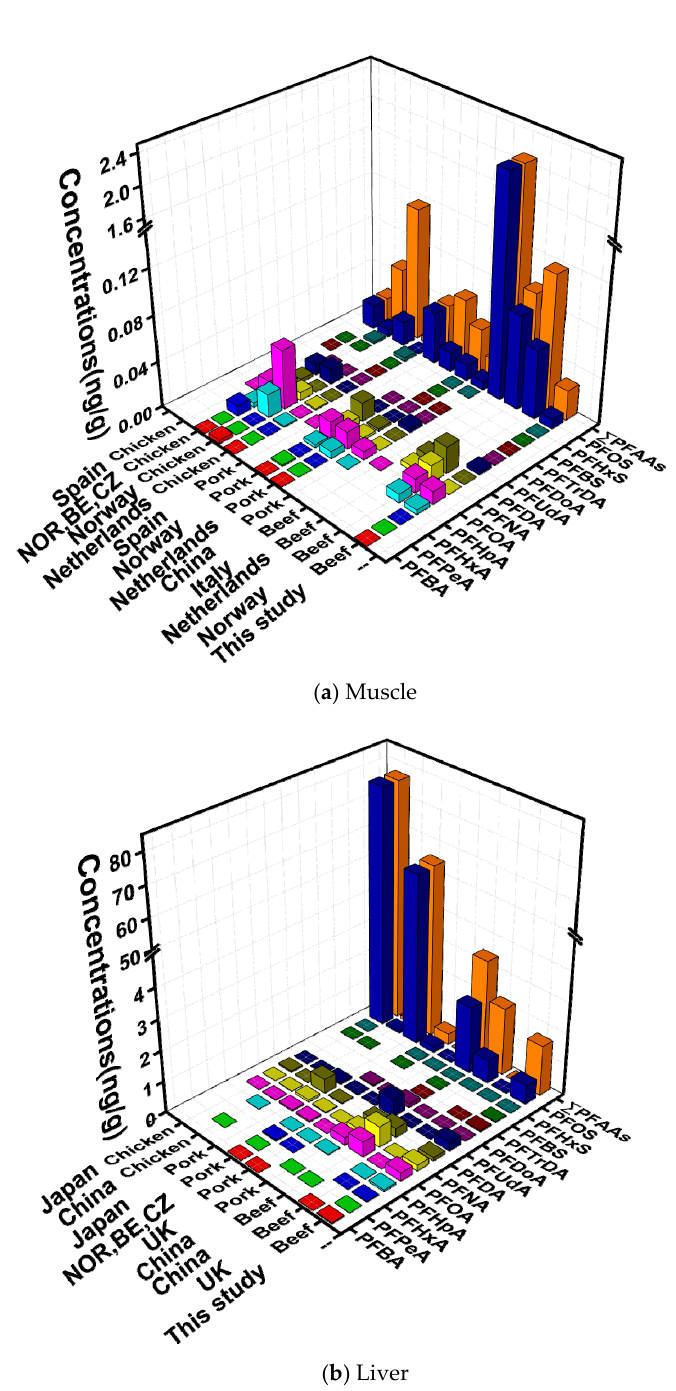
Figure 4. Comparison of the mean concentrations (ng/g, wet weight) of PFAAs with other recent studies of animal muscle and liver samples (NOR, BE, CZ: Norway, Belgium, Czech Republic; no bar: no corresponding values; [16,22,36–41]).